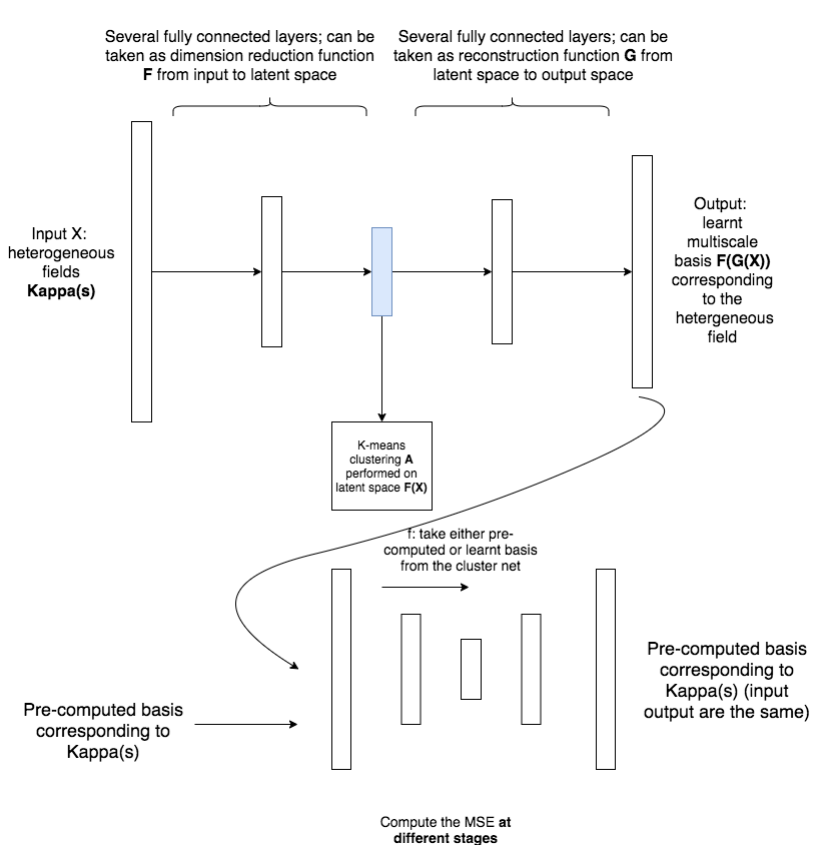
Figure 6. The complete